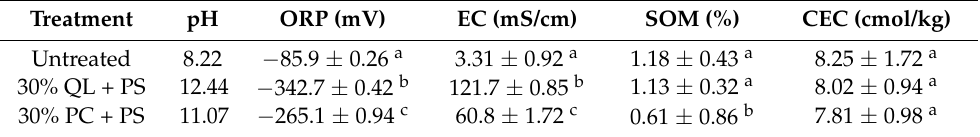
Table 3. Basic physical and chemical properties of the soil before and after